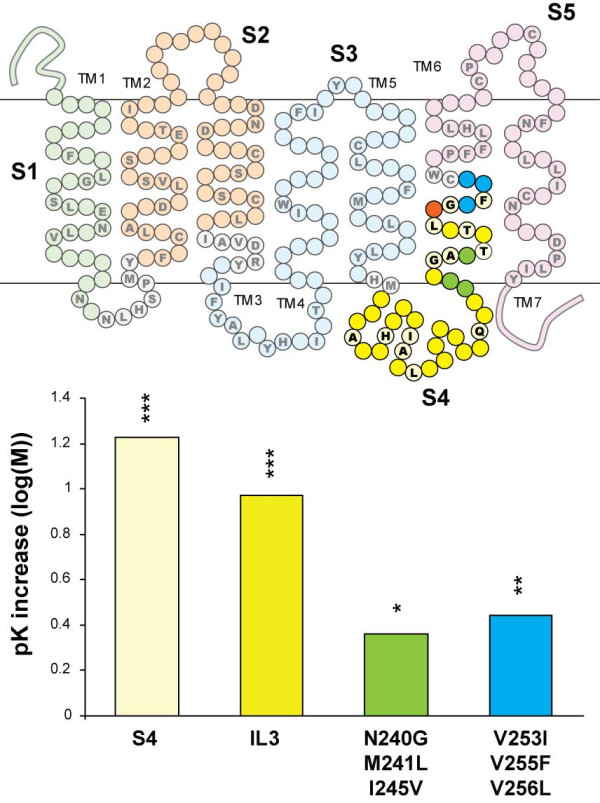
Experimentally determined increase in α-MSH affinity by mutations in segment S4. Experimentally determined increase in affinity (pK) afforded by mutations N240G/M241L/I245V (indicated in green), and V253I/V255F/V256L (indicated in blue) (i.e., exchanging amino acid residues in the MC4 receptor with the corresponding residues in the MC1 receptor), and swapping intracellular loop 3 (IL3, indicated in dark yellow) in the MC4 receptor with the corresponding in the MC1 receptor. Also shown is the increase in affinity for the whole S4 segment (S4, indicated in pale yellow). Significance (nonparametric Wilcoxon Rank Sum statistical test [29]) denoted as indicated in the legend to Fig. 2.